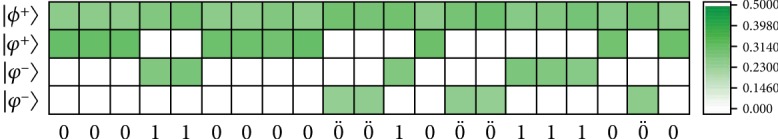
A stream of random numbers obtained by retrieving the King's measurements. In a game between Alice and the King, after the initial state |ϕ+〉 is distributed, a series of b values are randomly chosen by the King and the corresponding nonselective measurements in MUBs are implemented successively. Then Alice can “guess” the King's choice by her own measurement. The measured probabilities are represented by the color, and the identified random numbers are listed below.